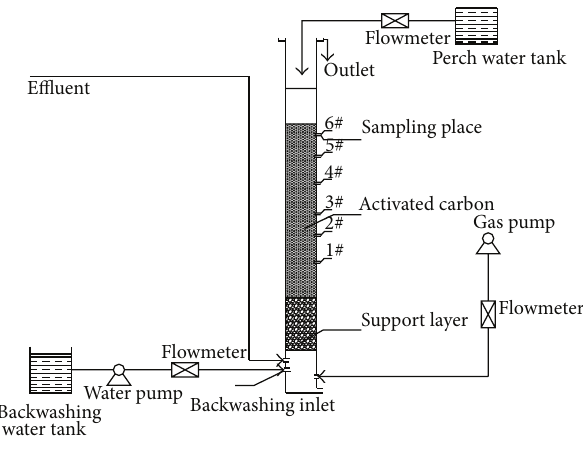
Figure 2: Biological activated carbon